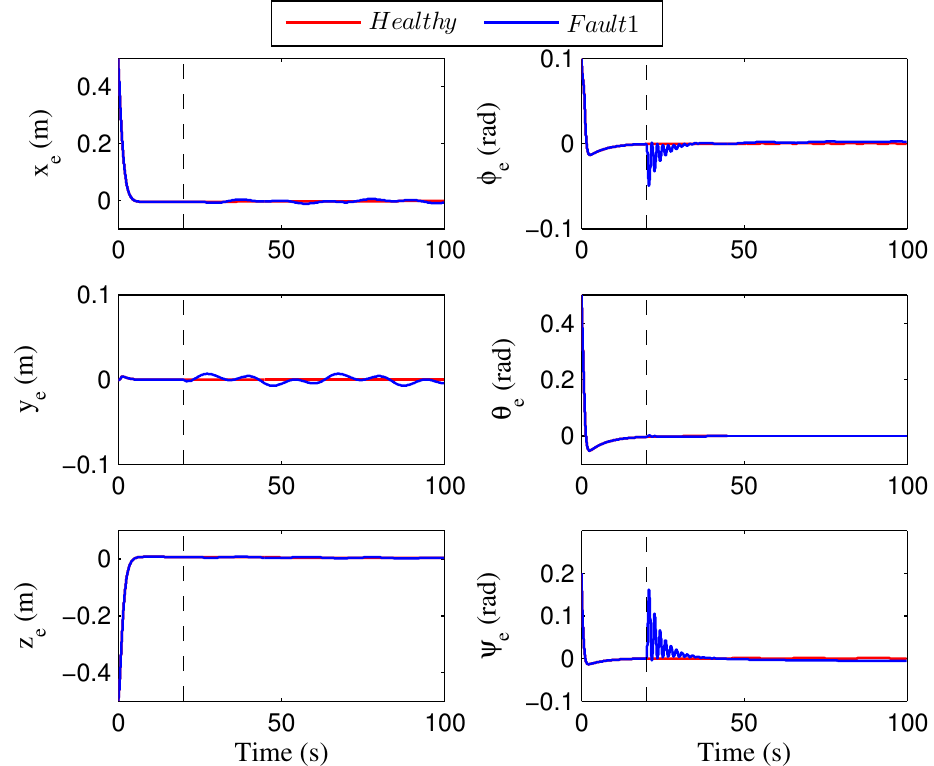
Figure 5. The position and attitude errors with fault